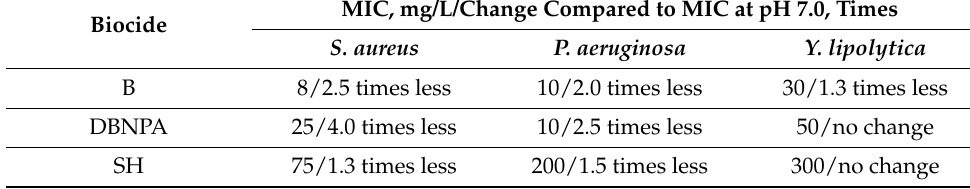
Table 4. MIC of the studied biocides for test-microorganisms after the addition of alkali (1 N NaOH) followed by neutralization with acid (7% HCl) from pH 9.0 to 7.0.